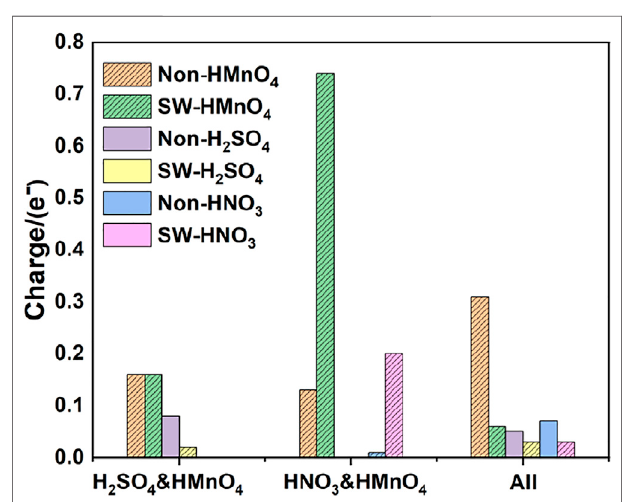
FIGURE 8 | Charge of HMnO 4 in the mix-component in the absence of water. The shadow indicates that this value is negative.